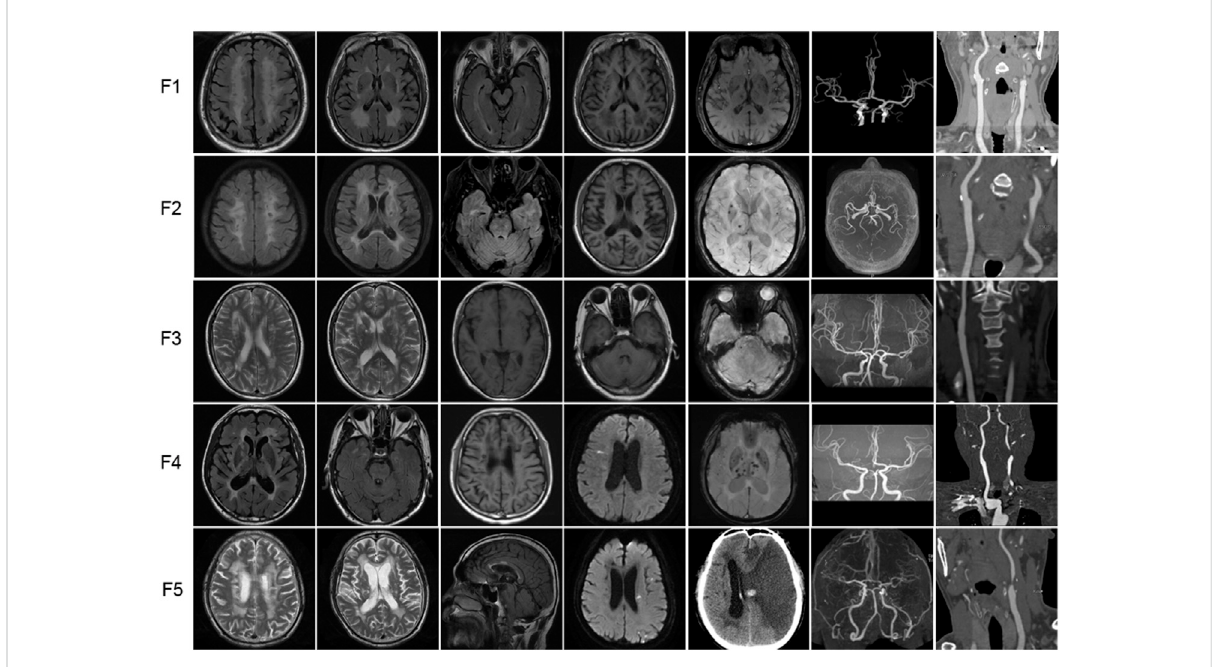
FIGURE 4 Representativeneuroimagesoftheprobandswithheterozygous HTRA1 pathogenicvariants.T2-weightedimagesor fl uidattenuationinversion recovery images of brain MRI to illustrate white matter hyperintensity. T1-weighted images or fl uid attenuation inversion recovery images of brain MRI to illustrate lacunar infarcts. DWI images showed acute lacunar cerebral infarction. SWI images to illustrate microbleeds. Brain MRA or CTA to illustrate stenosis of intracranial vessels. Cervical CTA to illustrate stenosis of cervical vessels. For F5 (patient II-4), cervical CTA showed severe stenosis at the beginning of left internal carotid artery. Brain CT after interventional treatment showed cerebral hemorrhage and large area cerebral